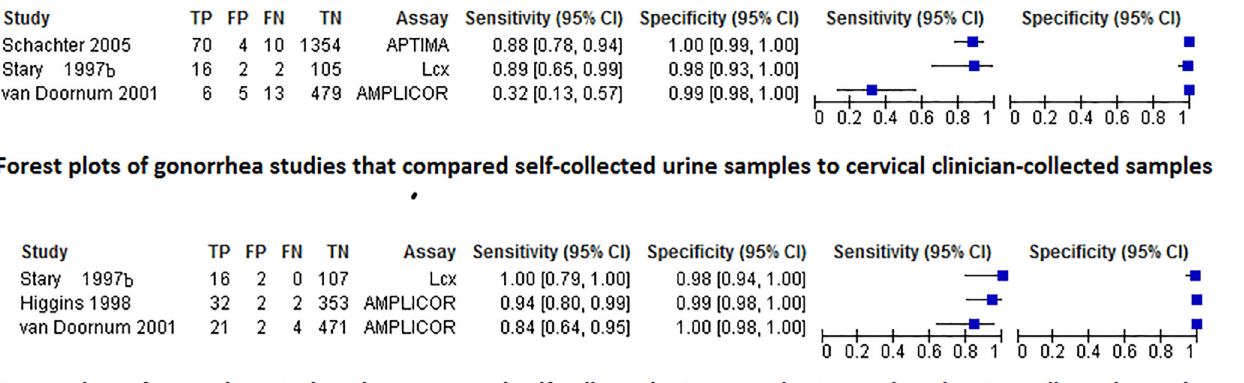
Fig 4. Forest plot of gonorrhea self-sampling compared to clinician